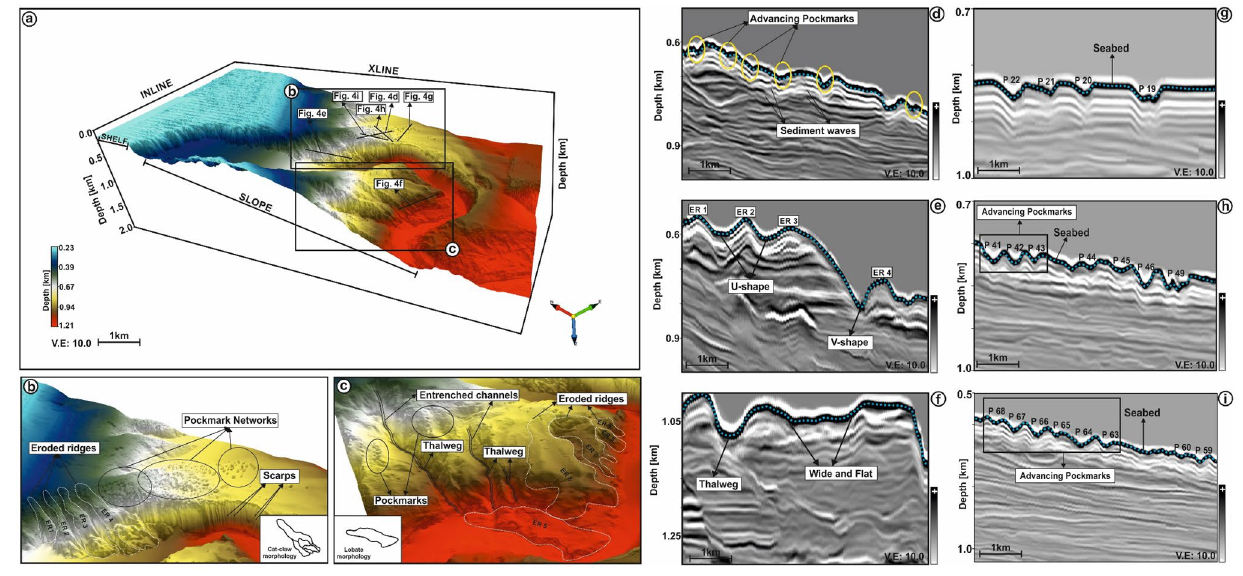
Figure 4. ( a ) TWT structure map of the seafloor. The seafloor is dissected by the Waitaki Submarine Canyon at the shelf break and further develops into a sinuous structure downslope; ( b – c ) Zoomed view of the NE and SW part of the seafloor. The NE portion of the seafloor is structured with eroded ridges (ER 1–4) and gullies with vertically stacked scarps. These eroded ridges show a distinct cat-claw morphology. Pockmarks are densely clustered over the northern ridge of the seafloor. In the SW portion of the seafloor, the eroded ridges (ER 5–9) show a distinct lobate morphology. Furthermore, the eroded gullies are entrenched in different channel belts; ( d – f ) Seismic profiles confirms the presence of these structures over the seafloor. Examples of mapped pockmarks displayed through seismic cross-sections ( g – i ). The pockmarks are associated with V-shaped depressions, which are stacked and closely spaced (typically known as advancing pockmarks). (The above maps are prepared using licensed version of Corel Draw v16 and OpendTect interpretation Suite v6.6.3).